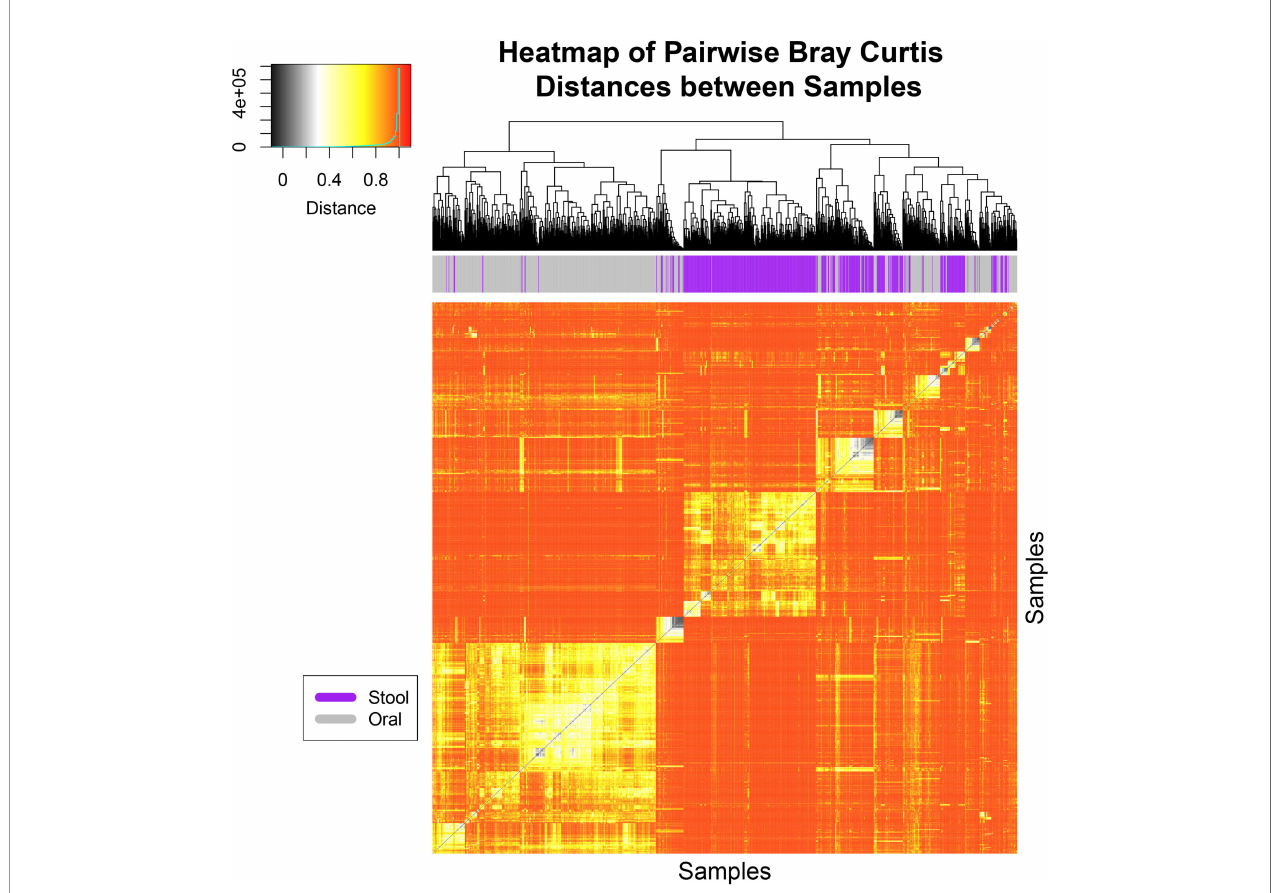
FIGURE 2 | Hierarchical clustering analysis of Bray-Curtis distances shows three major clusters. A heat-map and hierarchical clustering dendrogram is shown based on pairwise Bray-Curtis distances for all samples collected from patients and colored at the top by body site. Hierarchical clustering was conducted for both axes, and is only visualized on the x-axis. Three major clusters of samples can be seen where the oral samples (left in gray), stool samples (middle in purple) clustered separately from a third group which had a mixture of stool and oral samples (right in both gray and purple). The heat-map is colored from black (0) to red (1) for the Bray-Curtis Distances in which speci fi c values and counts are seen in the inlaid